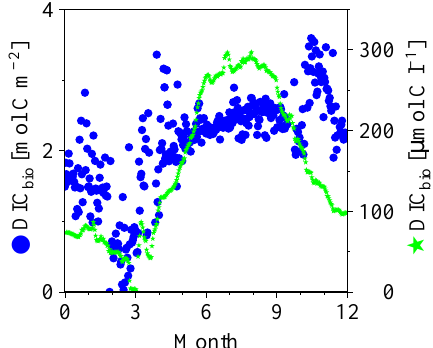
Fig. 5. Annual cycle of biological DIC uptake. We show the annual cycle of biological DIC uptake, integrated from hourly values, i.e. accumulated diel changes. The mixed layer inventory of biological DIC uptake (left y-axis, blue) was obtained by dividing the biolog- ical DIC concentration change (right y-axis, green) by the MLD as reported by Shadwick et al. (2011a).The production rates were computed from the slopes of the DIC